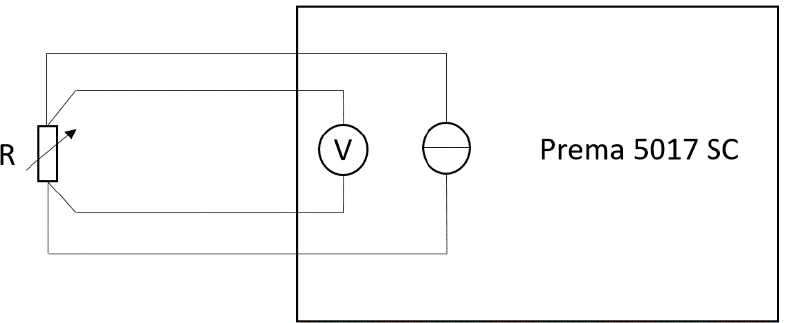
Figure 3. Block diagram of the measurement setup. Four-terminal sensing with separate wiring for current and voltage eliminates the influences of the measuring lines.